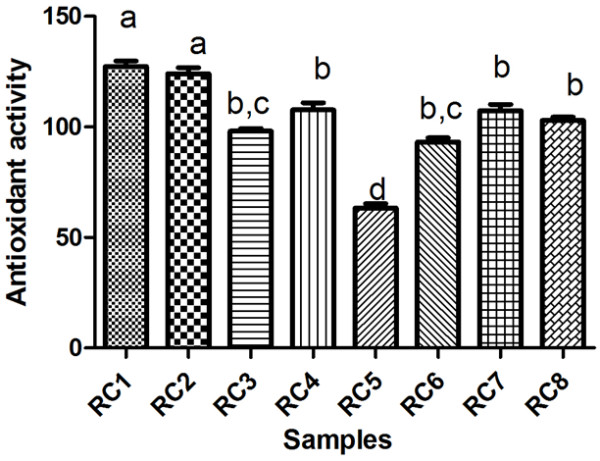
Antioxidant activity expressed as μM Trolox/100 g frozen rose hips.